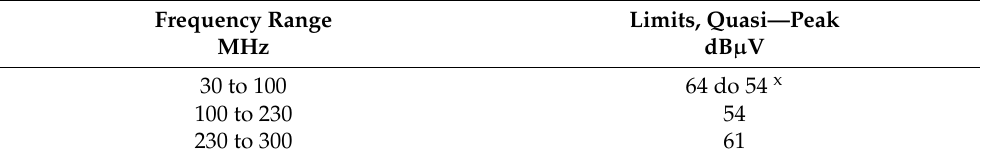
Table 2. Disturbance voltage emission limits at the power supply terminals for the frequency range 30 to 300 MHz for CDNE method.